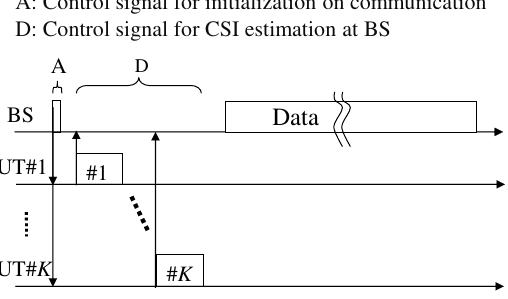
Figure 2. Frame format of multi-user multiple-input multiple-output (MU-MIMO) without channel state information (CSI)